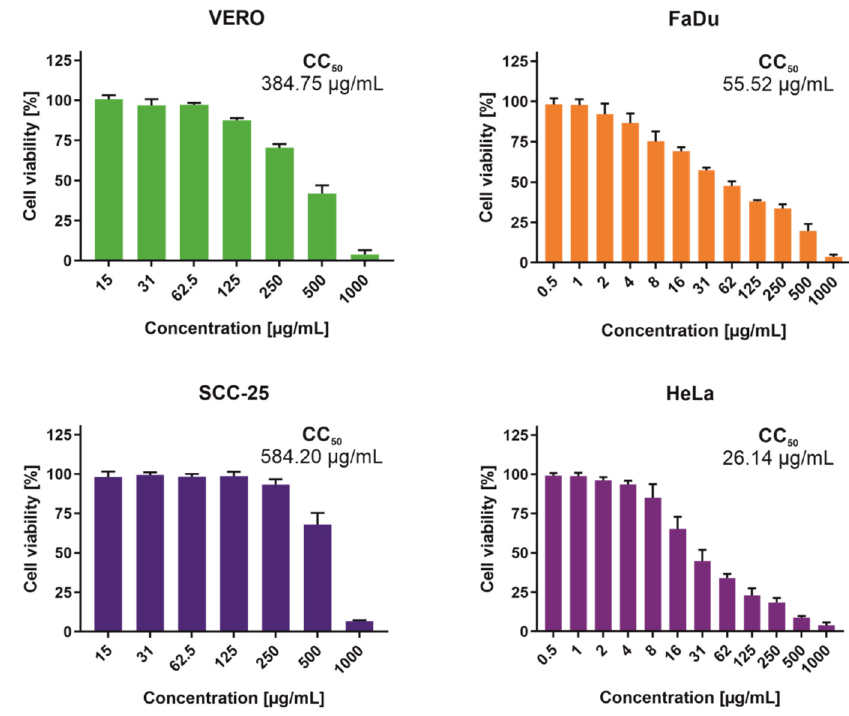
Figure 4. Cytotoxicity of ethyl acetate extract from M. polymorpha